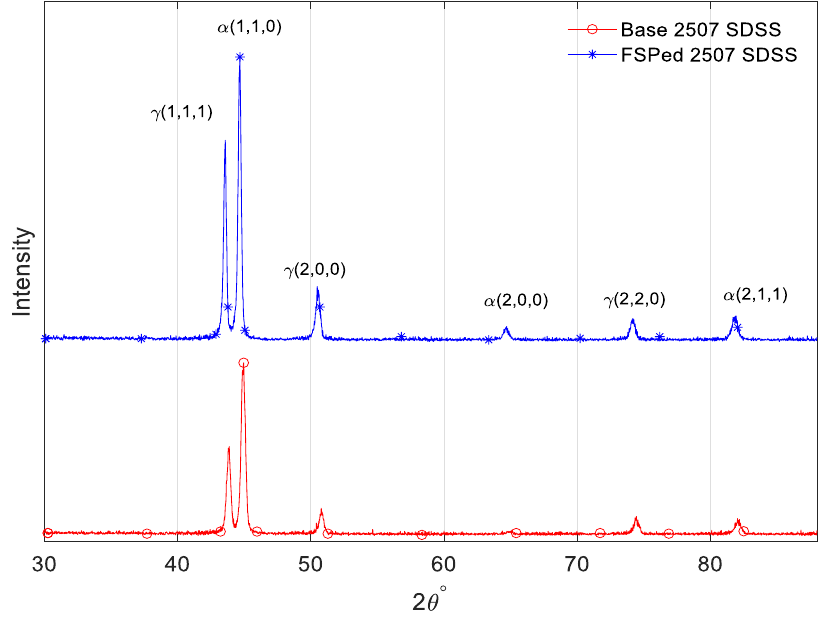
Figure 10. XRD of BM and FSPed 2507 SDSS.